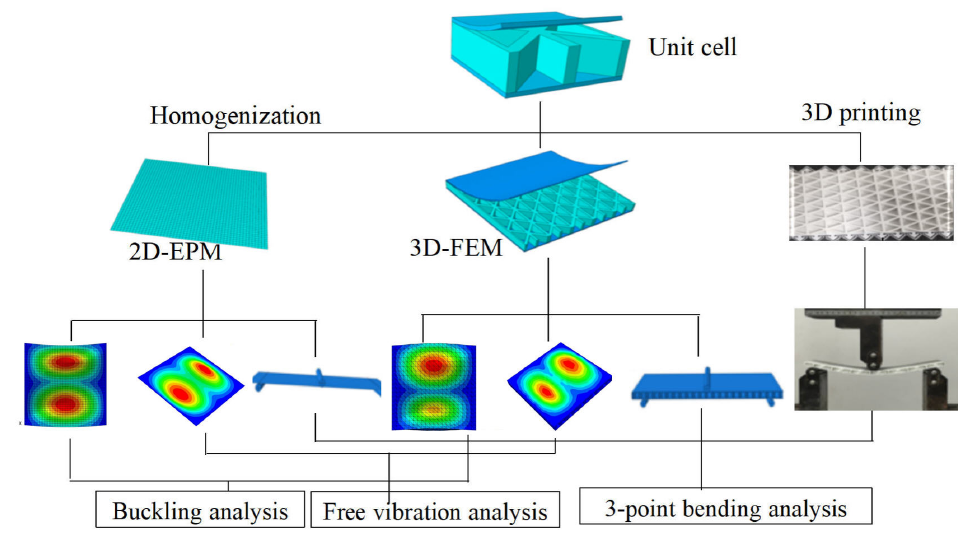
Figure 3. Comparison analysis process of the 3D-FEM, 2D-EPM, and experimental